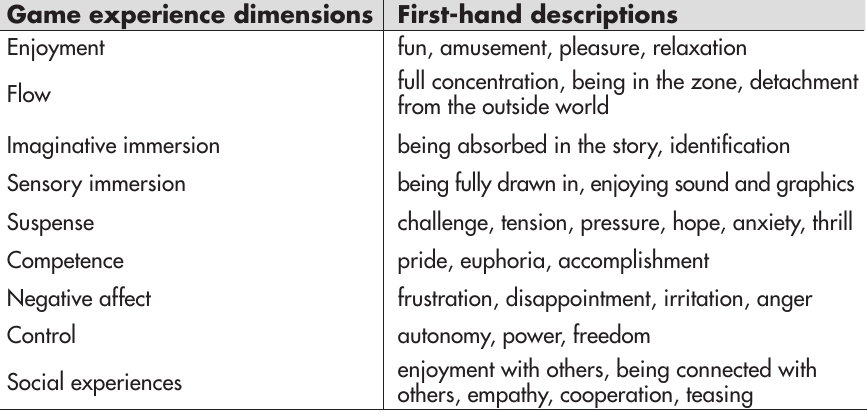
Table 1 Categorization of digital game experience dimensions with corresponding fi rst-hand